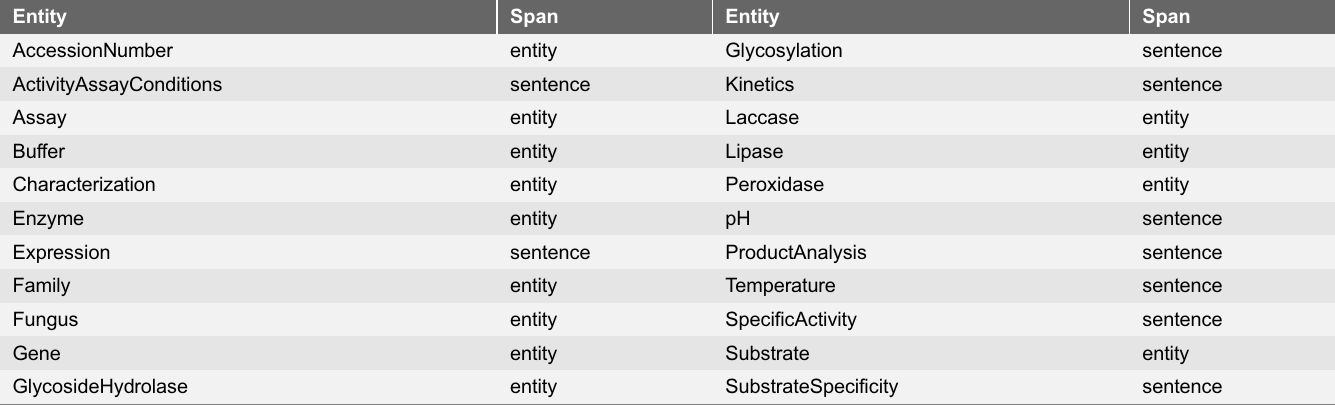
Table 2. mycoSet